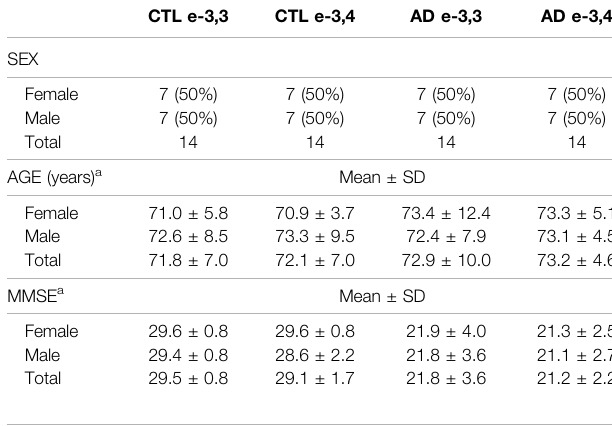
TABLE 1 | CSF participant characteristics. The table includes sex, age, and MMSE measures of the 56 participants in this study. The ratios of APOE genotype (-e3,3 or e-3,4) and sex was matched across all